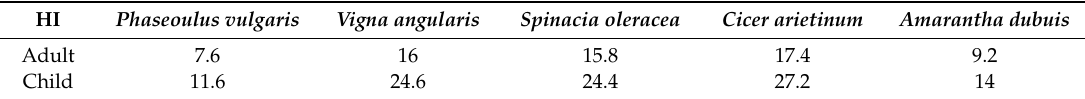
Table 6. Hazard index (HI) of Cr T , Cr(VI) and Cr(III) in vegetables grown in soil spiked with Cr(VI) for adult and